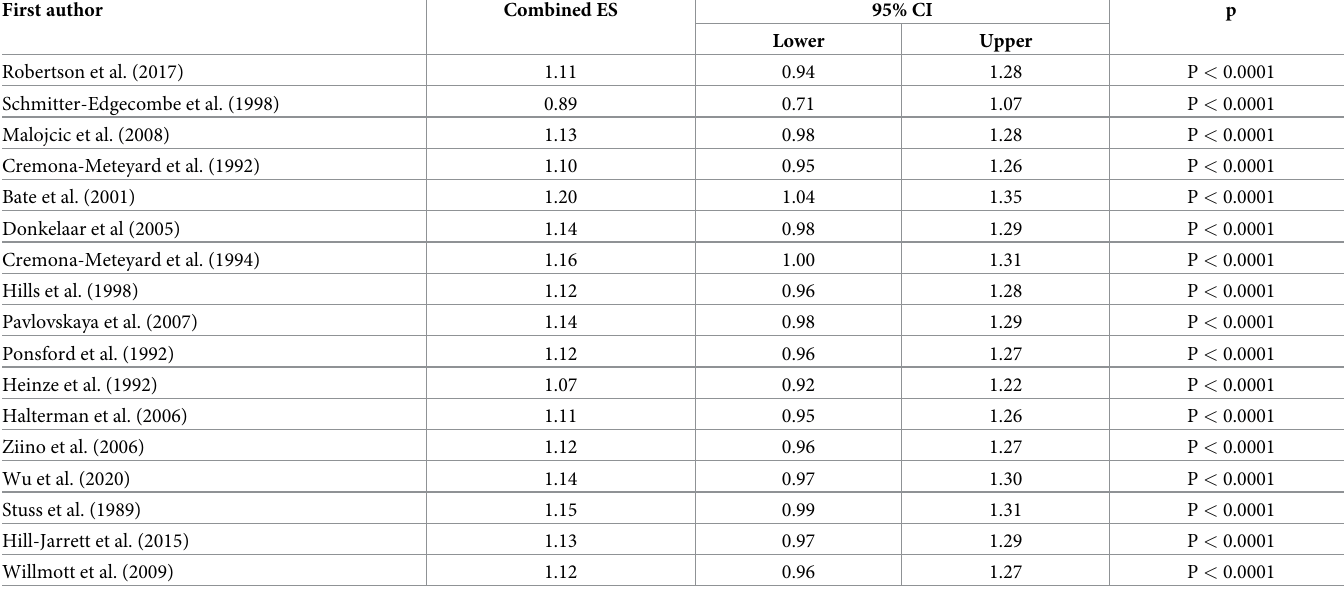
Table 6. The outcomes of a sensitivity analysis of studies used to estimate the combined effect size for reaction time.